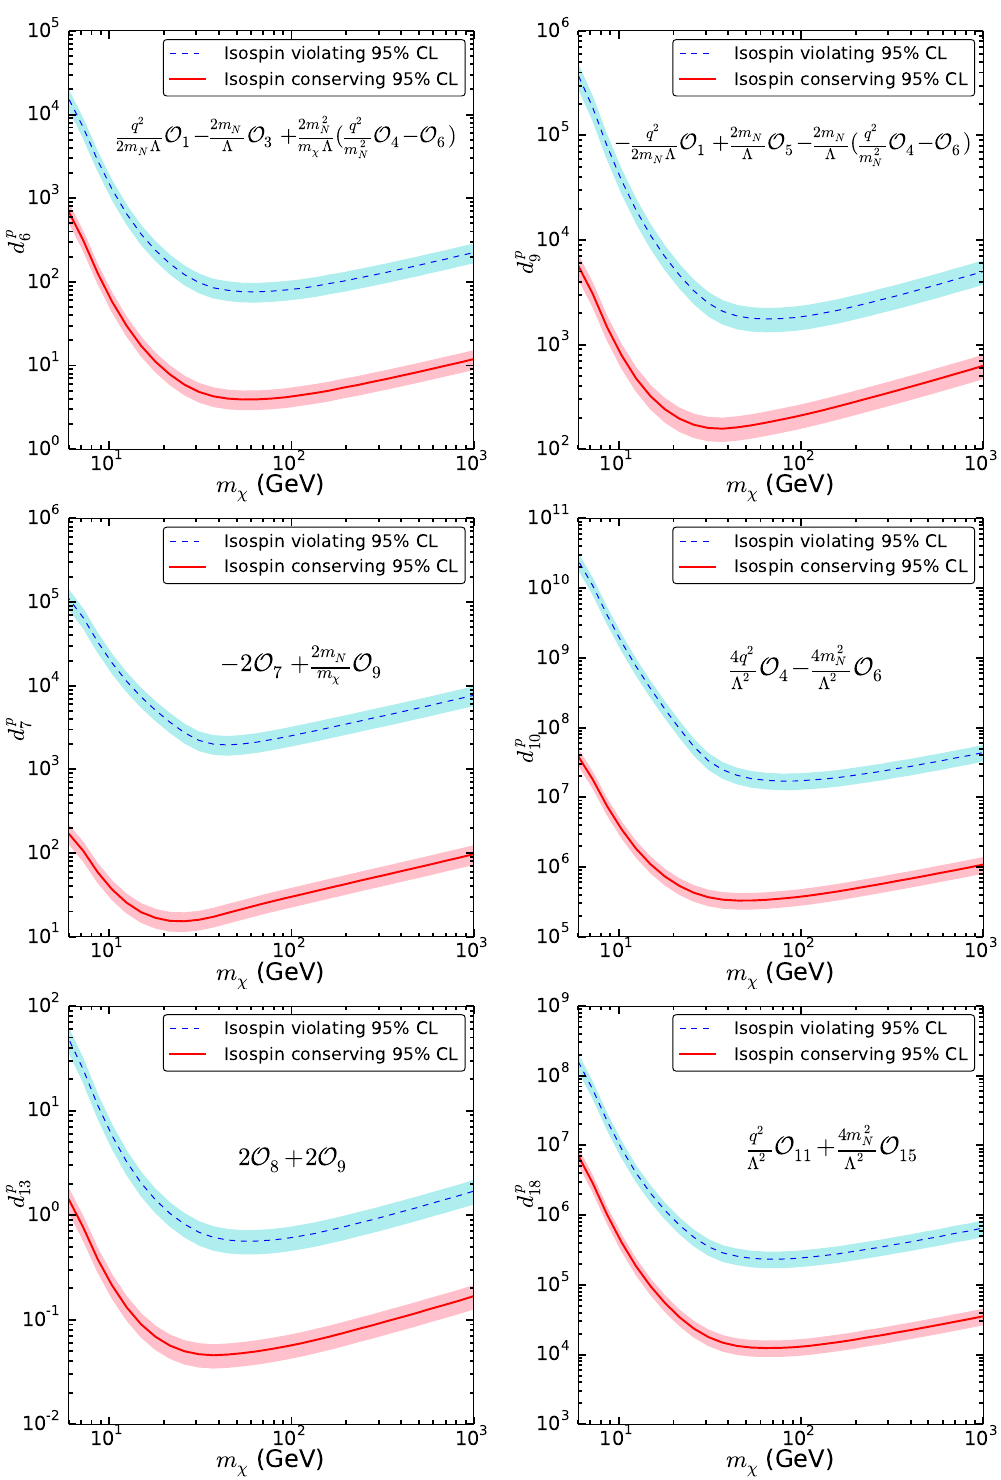
Figure 8 . The 95% CL upper limits of all other couplings in eq. (4.3) except d 12 .